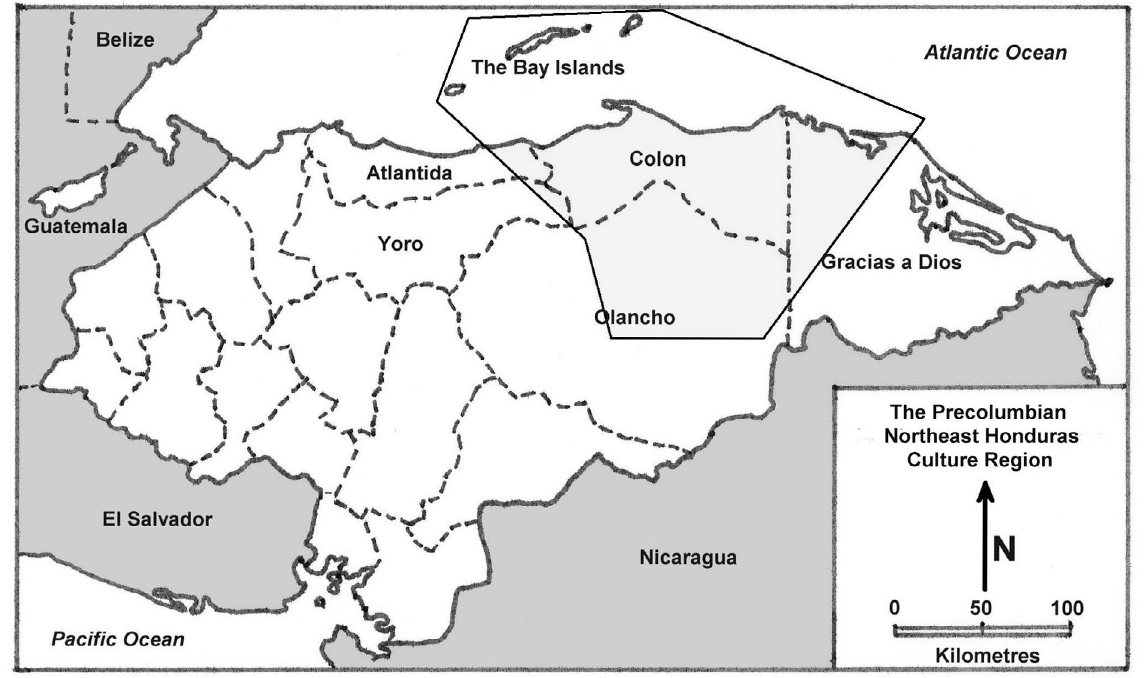
Figure 1. Map of Honduras, detailing the Northeast Honduras Region, including the political Department of Bay Islands, Colon, northern Olancho and western Gracias a Dios (after Healy & Dennett